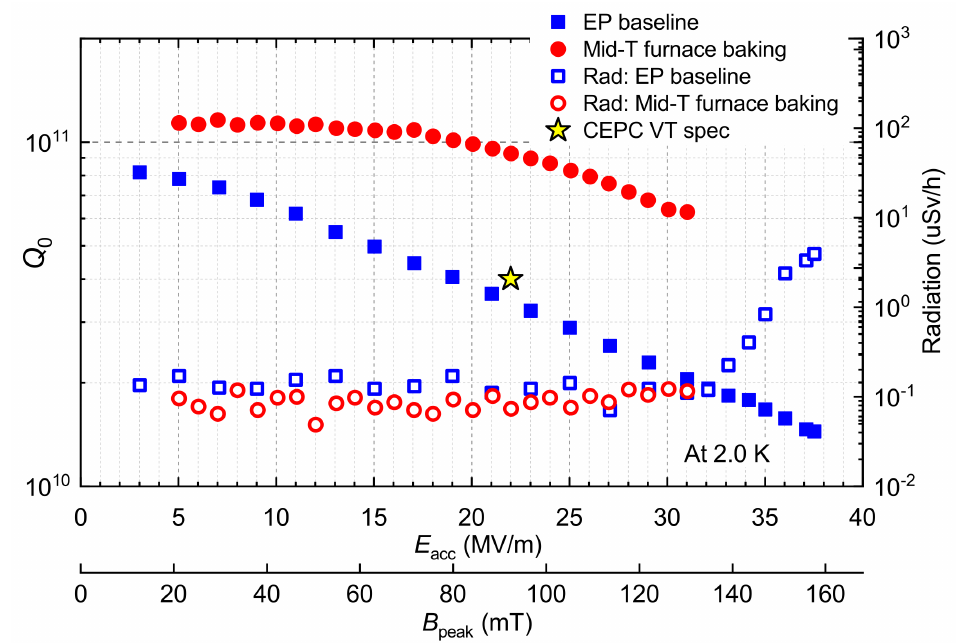
Figure 1. Vertical test results of 650 MHz SRF cavity (Blue: processed with EP; Red: processed with mid-T furnace